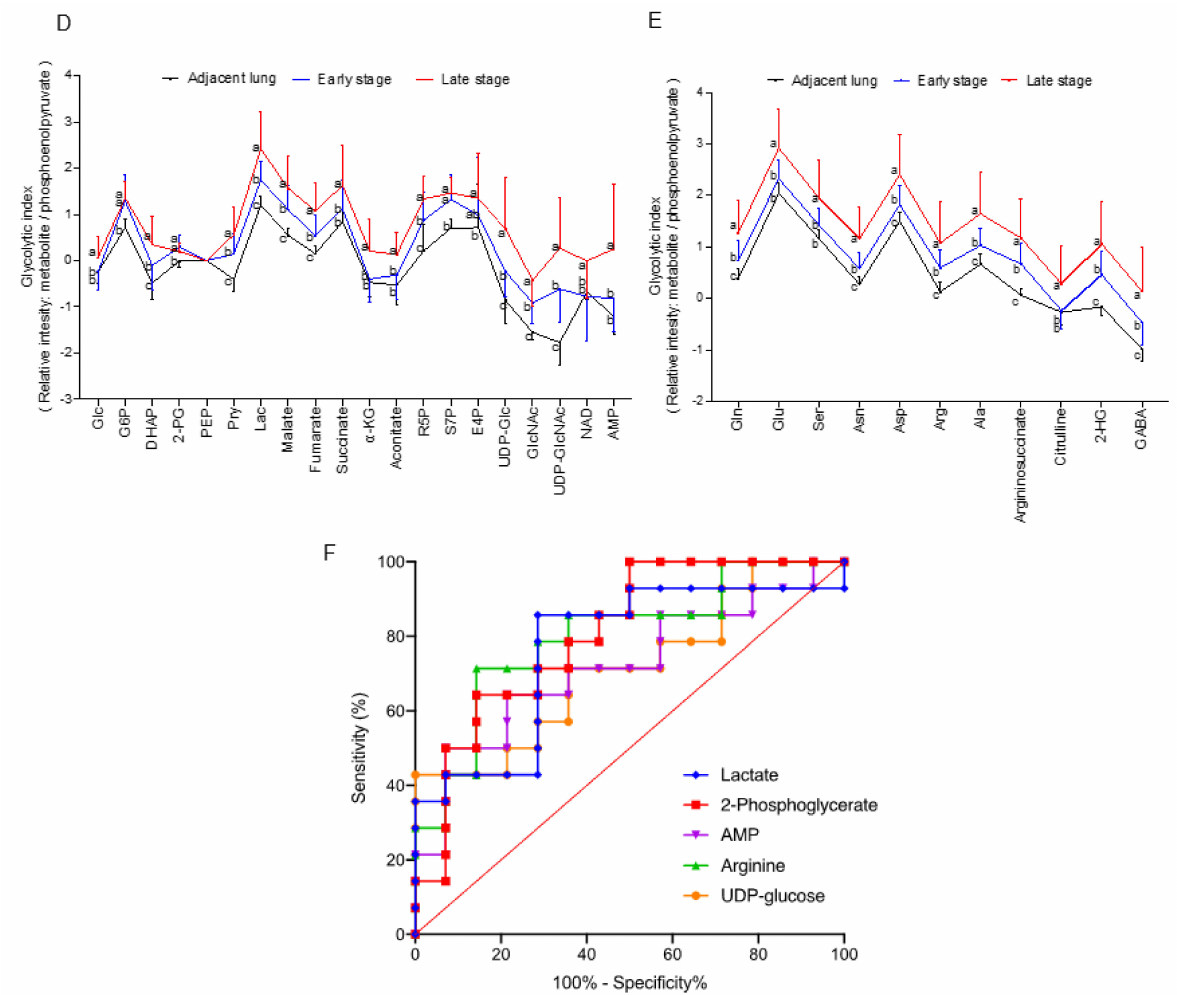
Figure 1. Discover stage-sensitive tumour metabolomics markers in paired NSCLCs ( A ) OPLS-DA of tissue samples for NSCLC and paired adjacent lungs; ( B ) VIP analysis on important metabolites that distinguish NSCLC from adjacent lungs; ( C ) Multivariate model of volcano plot analysis identifies significantly changed metabolites between tumours and paired lungs based on the selection criteria of VIP > 1, p < 0.05, R < 0.05, and fold-change > 2. Glycolytic index of metabolites (metabolites/PEP ratio) in ( D ) lactate metabolism pathways and ( E ) gluconeogenic amino acids of NSCLCs. Variables without common letter differed at p < 0.05. ( F ) ROC curve of each potential stage-sensitive biomarkers in paired NSCLCs. The ROC curve was plotted using GraphPad Prism